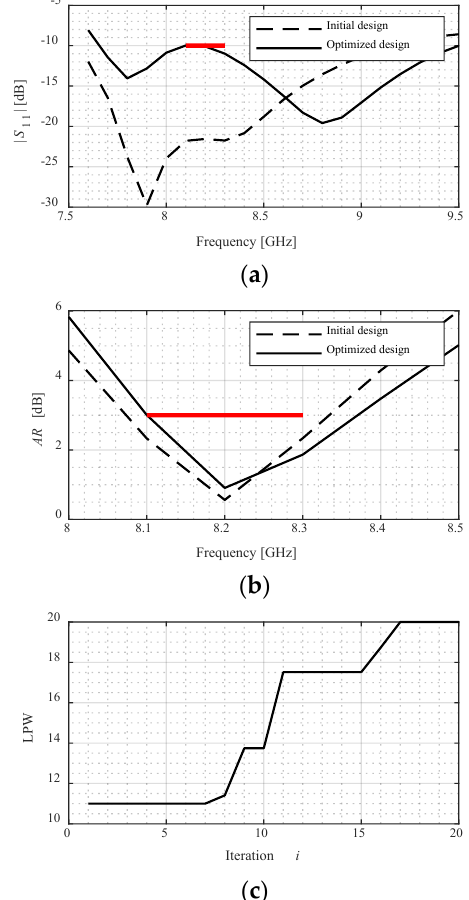
Figure 10. Numerical results obtained for Antenna IV using the proposed algorithm incorporating multi-fidelity model management and adaptive penalty coefficients: ( a ) reflection responses, ( b ) axial ratio responses, ( c ) evolution of the model fidelity. The horizontal lines represent the design specifications.